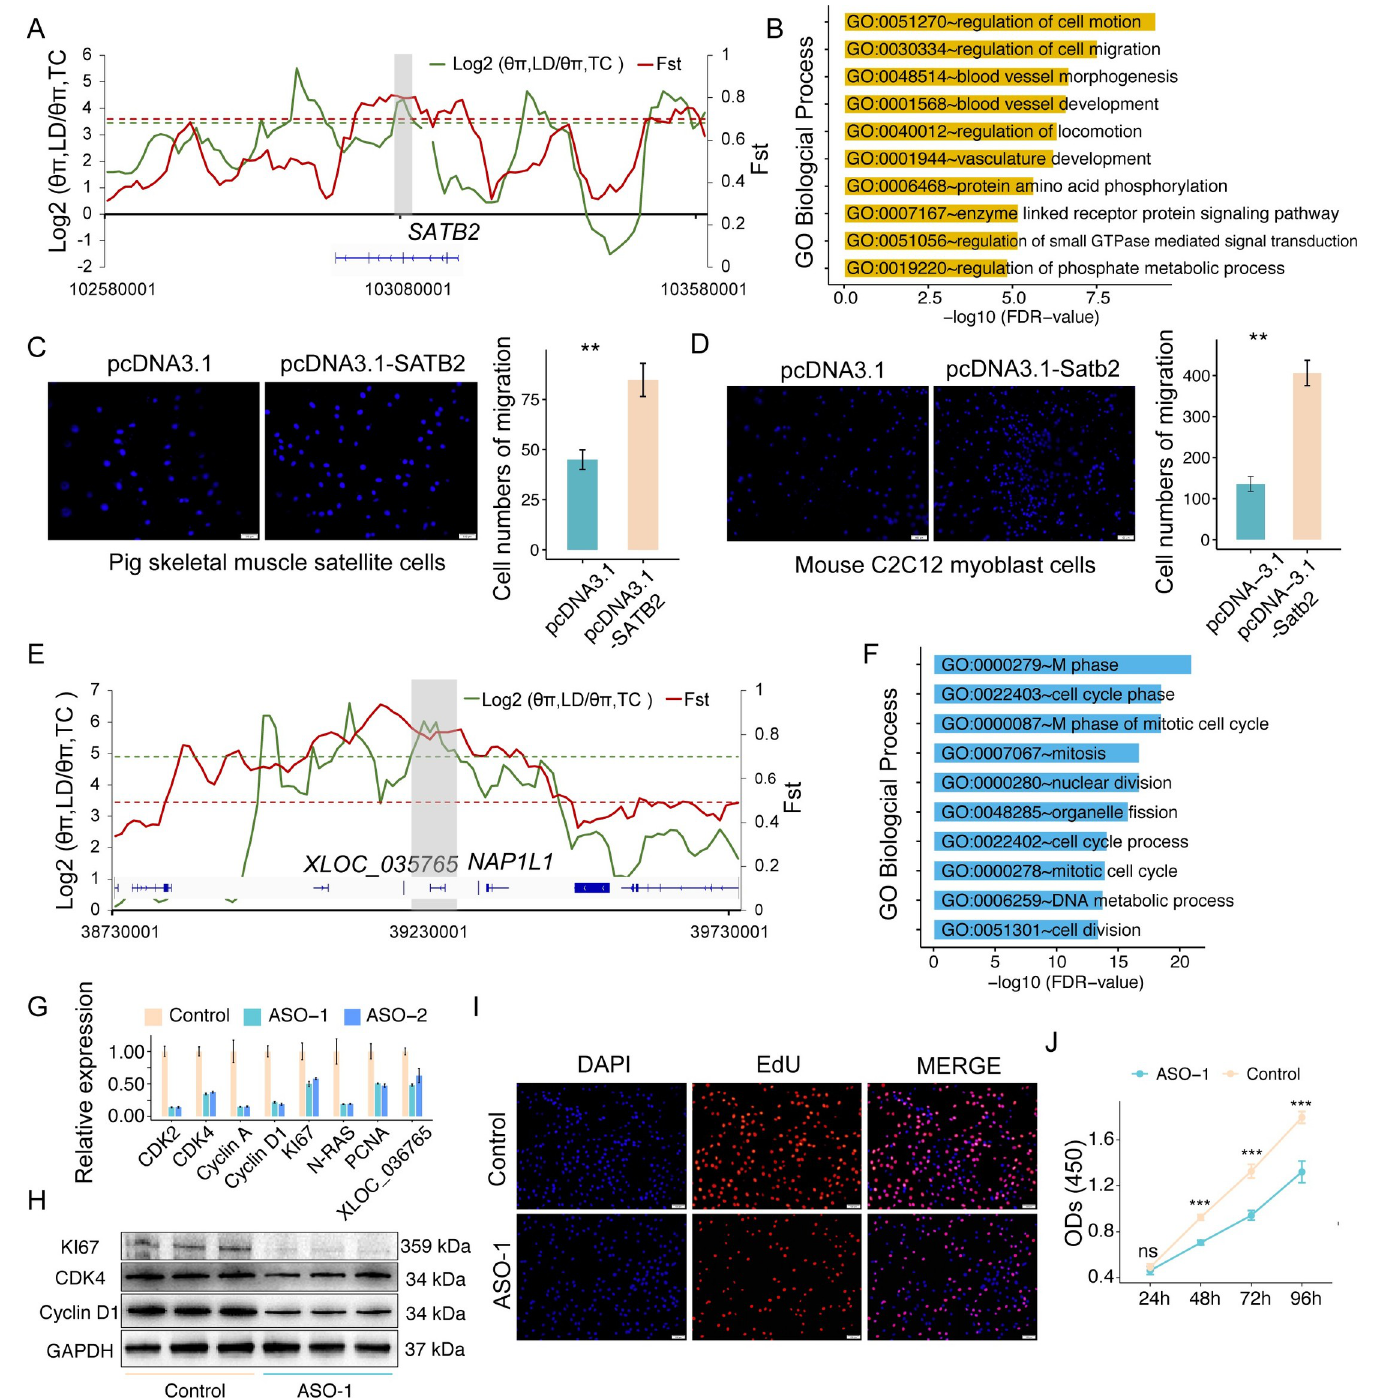
Fig 6. Function analysis of SATB2 and XLOC_036765 . ( A ) The θ ratio and F ST values around the genomic region of the SATB2 gene. ( B ) GO enrichment analysis of the genes co-expressed with SATB2 during skeletal muscle development. ( C-D) Transwell assay showing the change of migration ability after overexpressing SATB2 in pig SkMCs ( C ) and mouse C2C12 myoblast cells ( D ). ( E ) The θ ratio and F ST values around the XLOC_036765 . ( F ) GO analysis of the genes co-expressed with XLOC_036765 during skeletal muscle development. ( G-H ) qRT-PCR ( G ) and western blot ( H ) analysis of the expression levels of muscle proliferation and cell cycle markers following XLOC_036765 knockdown in pig SkMCs. ( I ) EdU assay for proliferation of pig SkMCs following XLOC_036765 knockdown. (J) CCK8 assay for the proliferation of pig SkMCs following XLOC_036765